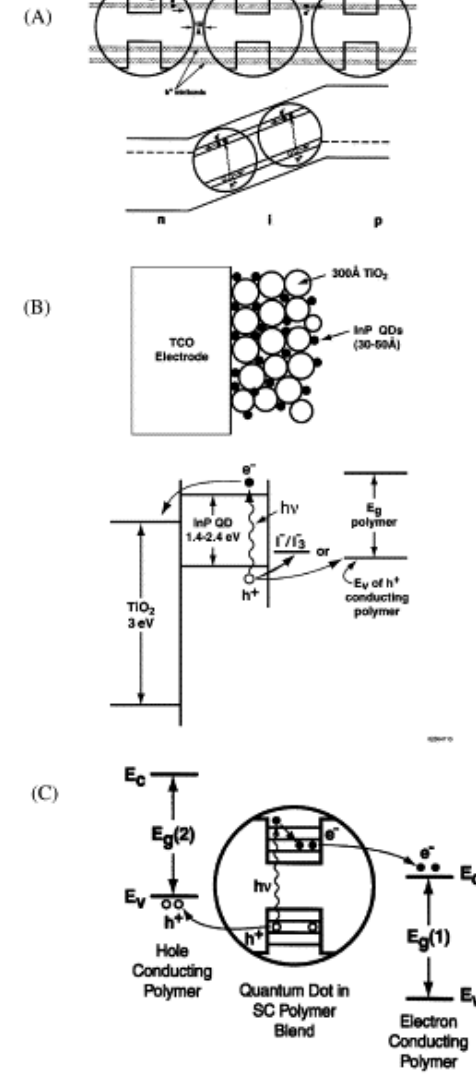
Figure 20. Solar cell with Qdots can be broadly classified in three categories: (A) P-I-N solar cell with a Qdots array, (B) Qdot sensitized and (C) Qdots dispersed [reprinted from publication [290], Copyright 2002, with permission from